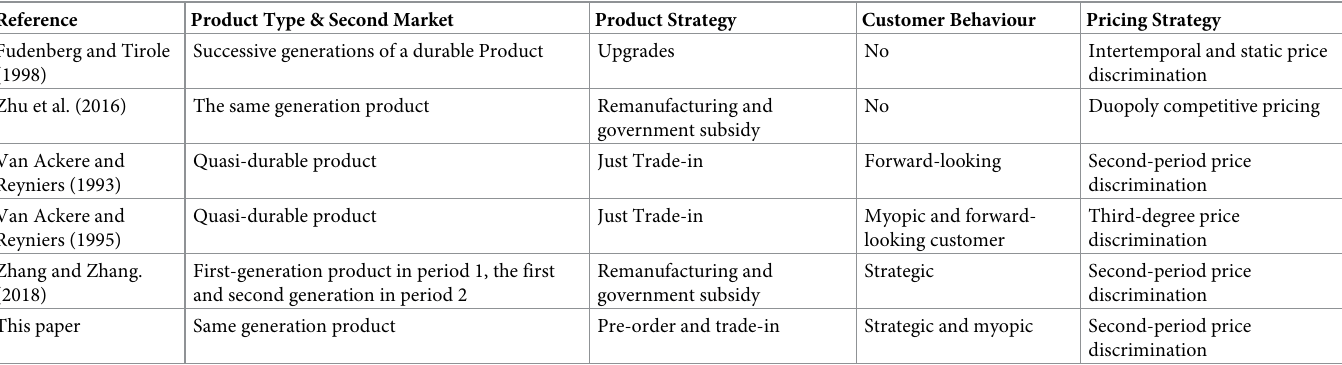
Table 2. Summary of research on trade-in strategy in two